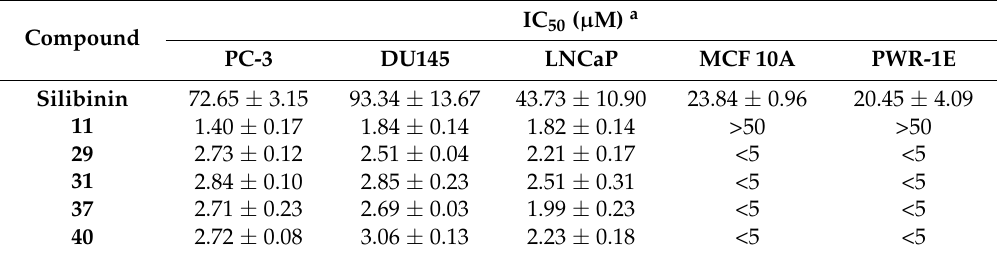
Table 2. Antiproliferative activity of selected derivatives against MCF 10A and PWR-1E cells.